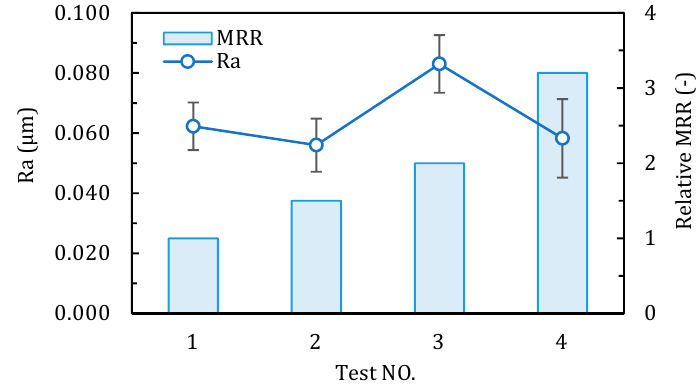
Figure 10. Surface roughness Ra and relative MRR of each test in case 2.